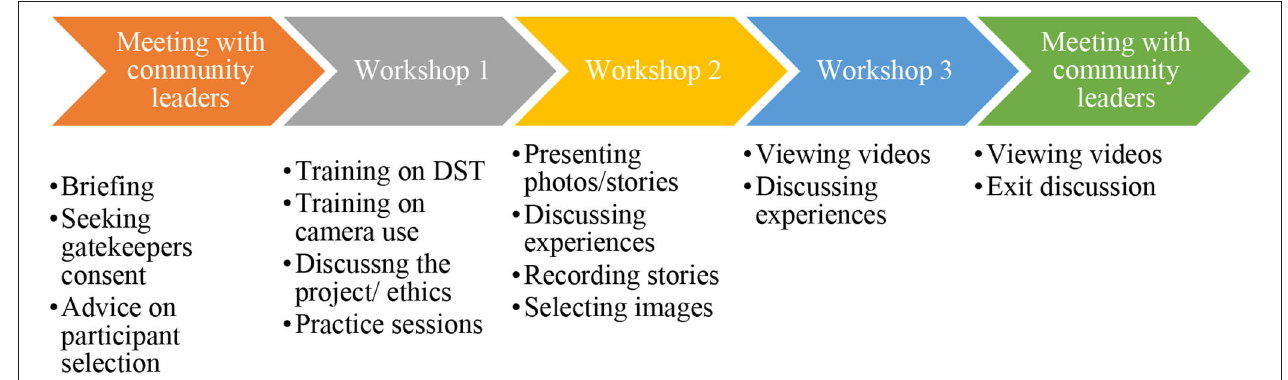
FIGURE 1 | Digital Story Telling